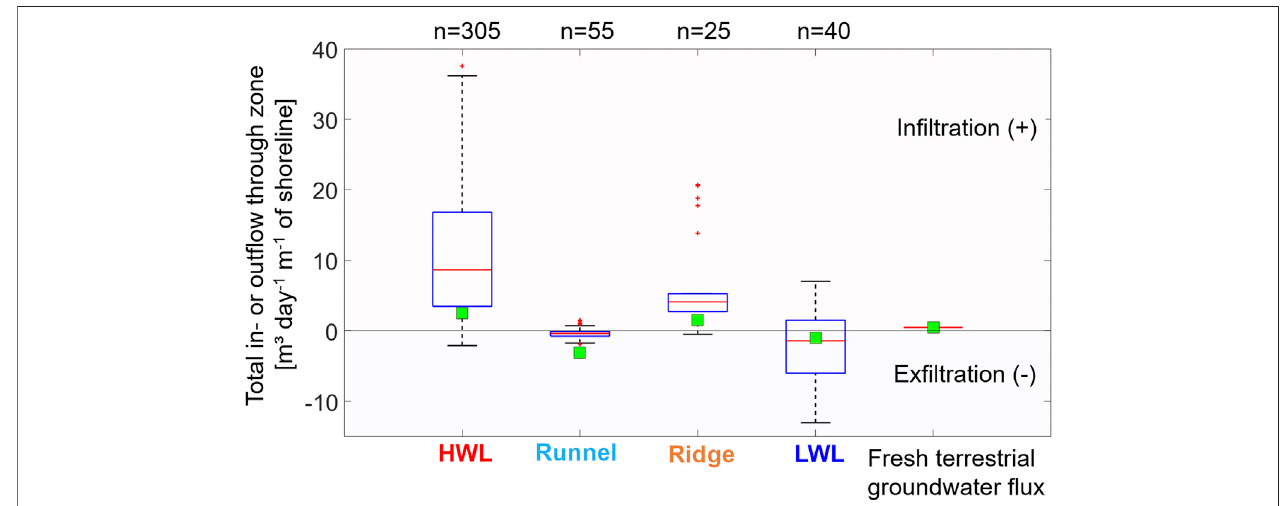
FIGURE7| Totalin-andout fl owwithinthein-andex fi ltrationzonesatthenorthernbeachofSpiekeroog(intertidalzone)for1mshoreline.Fortotalwaterbudgeting, fresh groundwater fl ux (estimated with 0.75 m 3 per day and meter of shoreline from Beck et al. (2017)) has to be considered as additional proportion in fi ltration. Green squaresindicateresultsfrommodelswaterbudget(Grünenbaumetal.,2020).Reddotsarevaluesthataremorethan1.5timestheinterquartilerangeawayfromthetop or bottom of the box. Red line indicates median of boxplot. Number of statistics ( n ) is given above.